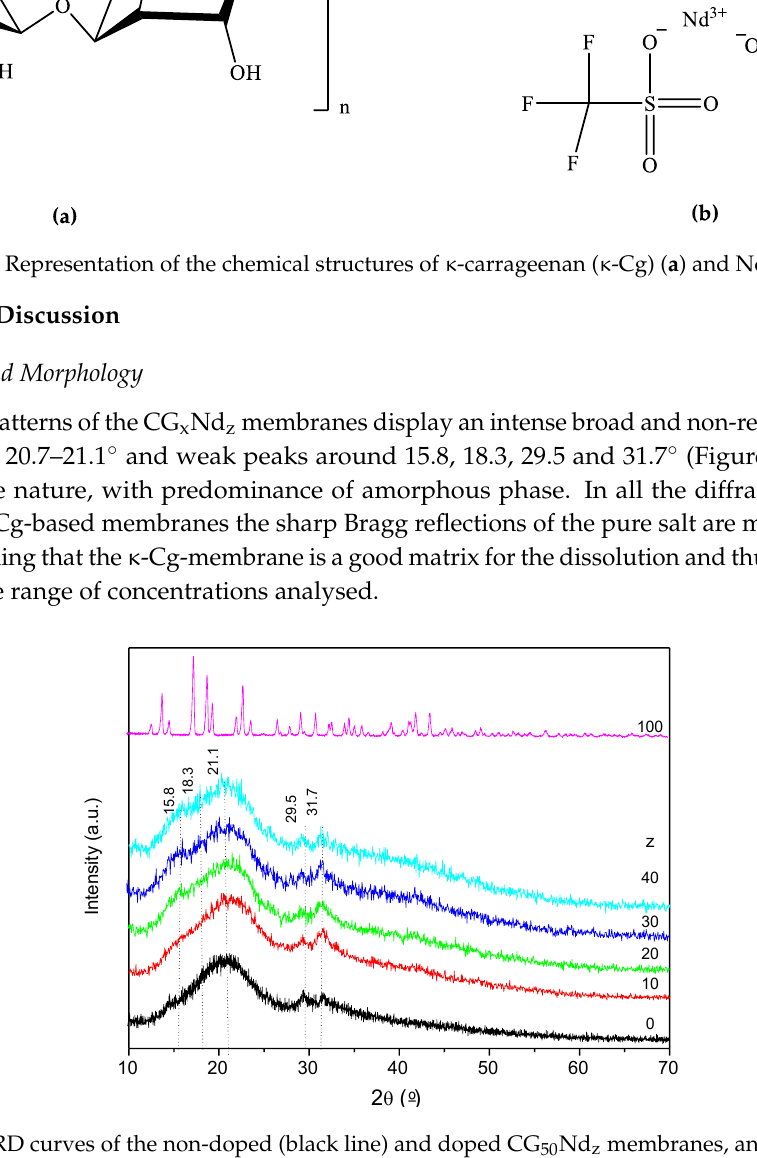
Figure 2. XRD curves of the non-doped (black line) and doped CG 50 Nd z membranes, and of NdTrif 3 (pink line).